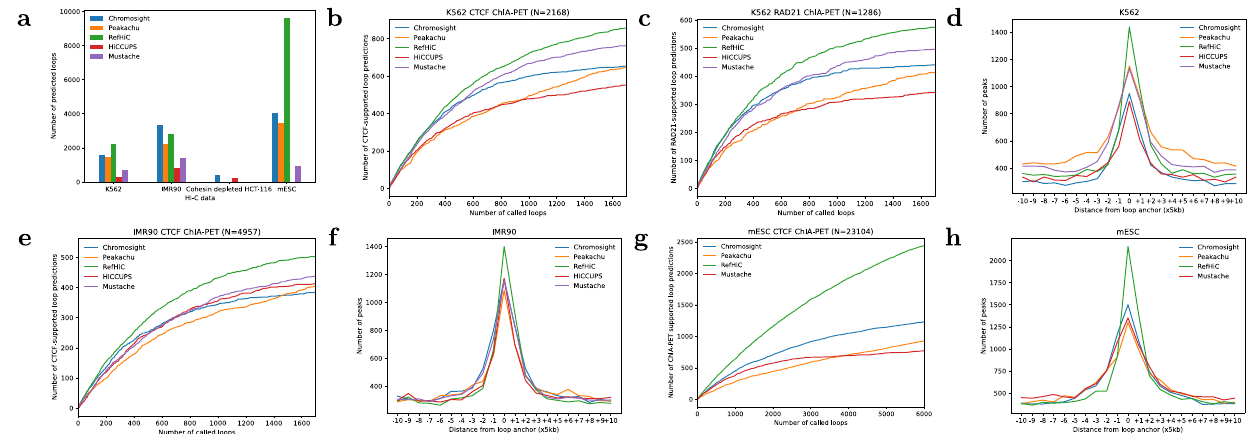
Fig. 3 | Loop detection in Hi-C data from human K562, IMR90, and cohesin- depletedHCT-116 cells, aswellasmouseESC.a Numberof loopsidenti fi ed inHi- C datasets obtained in each data set (human data: test chromosomes 15 – 17 only; mouse data: all autosomes). Note that in HCT-116, one would not expect any cohesin-mediated loops. b , c Number of ChIA-PET/HiCHIP-supported loop pre- dictions, among the top predictions madeby RefHiC and other toolson K562 Hi-C